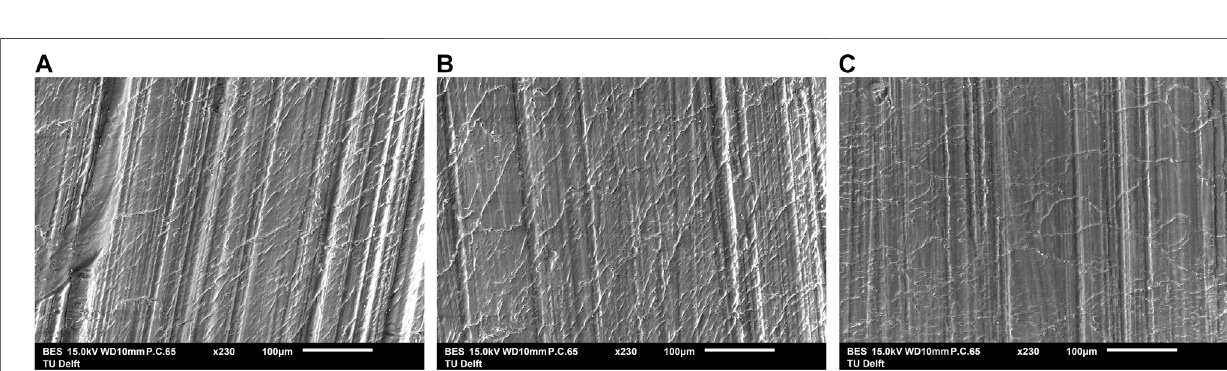
Frontiers in Materials |